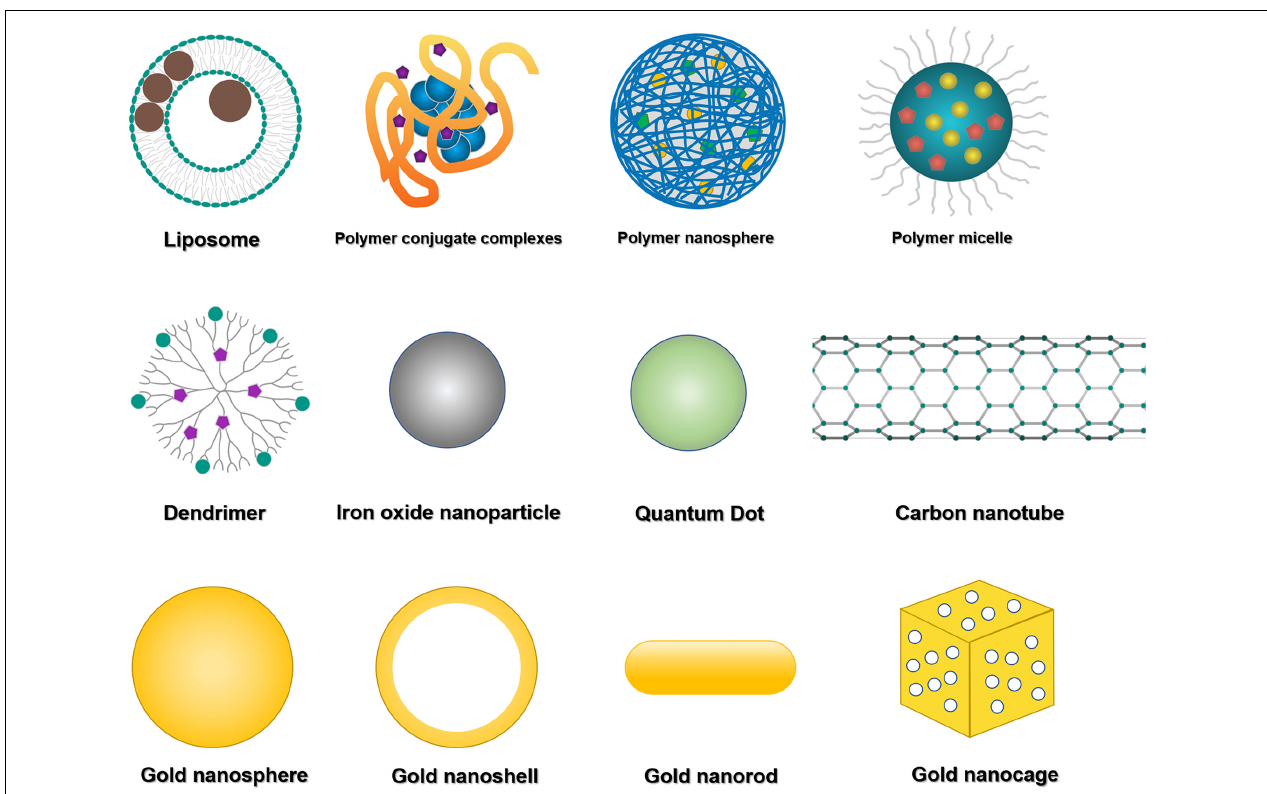
FIGURE 1 | Representative theranostic nanomaterials. The most commonly used theranostic platforms in basic research and clinical practice are liposomes, polymeric nanoparticles (mainly including polymer conjugate complexes, polymeric nanospheres, polymeric micelles, and dendritic polymers), and inorganic nanomaterials (mainly including iron oxide nanoparticles, quantum dots, carbon nanotubes, and various kinds of gold